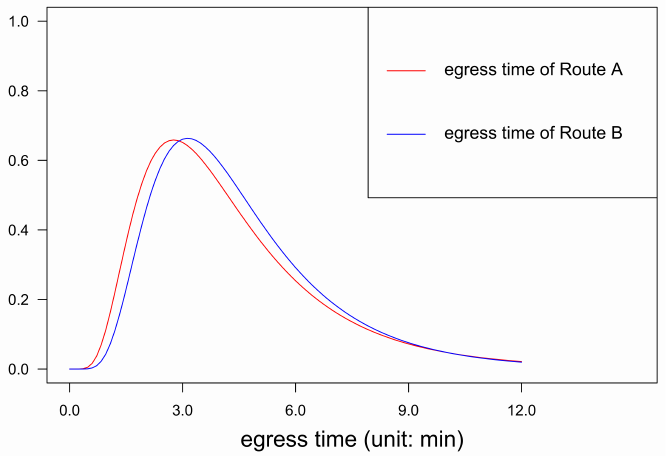
Figure 5. Density function curves of egress